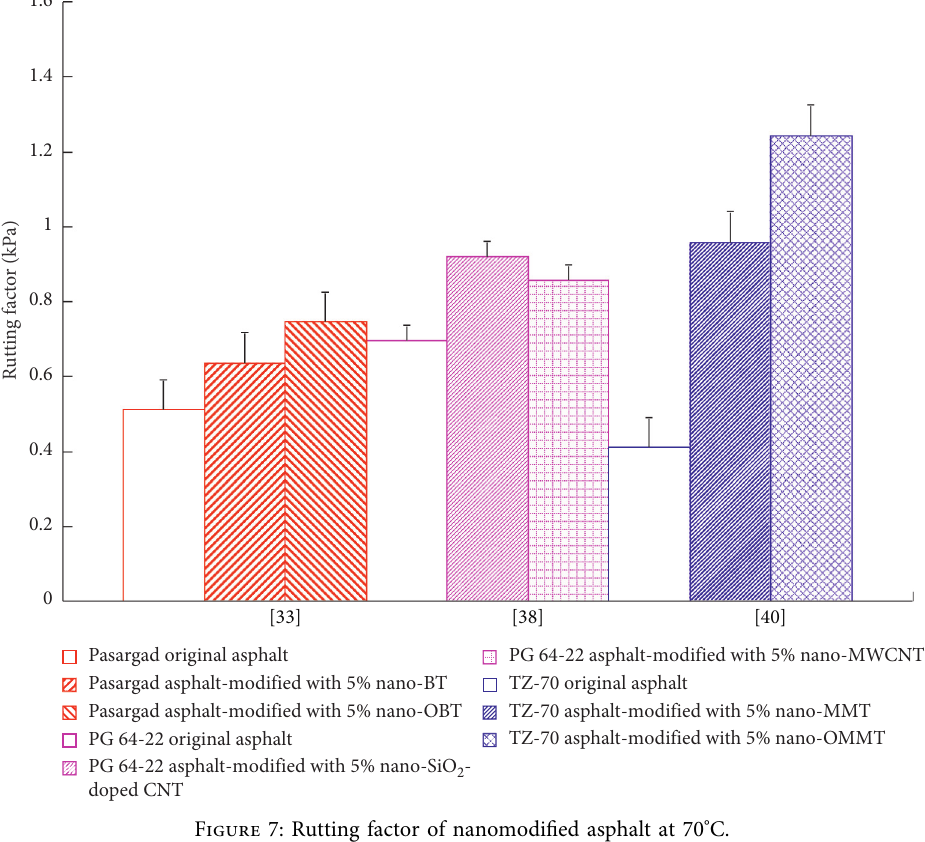
Figure 7: Rutting factor of nanomodified asphalt at 70 ° C.